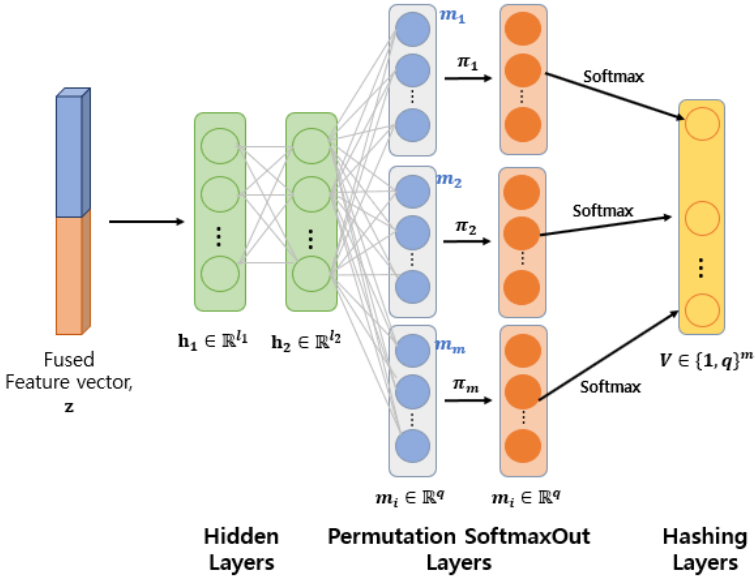
Figure 5. The permutation SoftmaxOut transform (PSMoT) module.